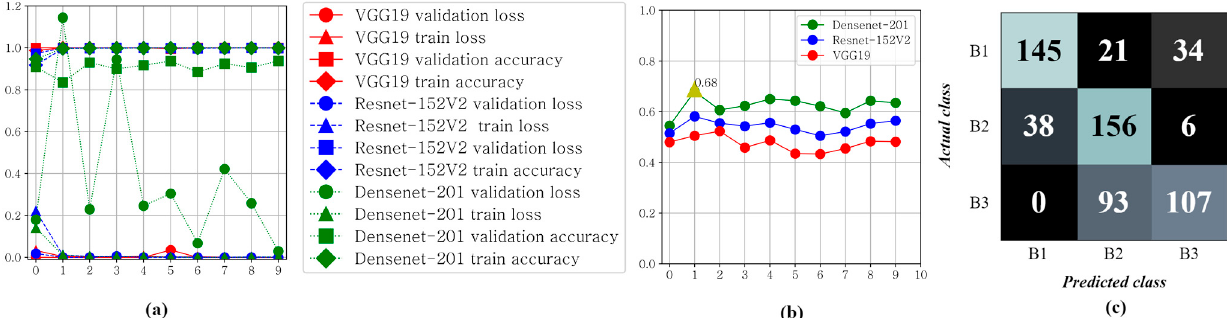
Figure 3. Training history and prediction results in Non-Thr dataset experimental environments: ( a ) Training history of Non-Thr dataset experimental envorinment; ( b ) Prediction accuracy of CNN models at each epoch; ( c ) Confusion matrix of Non-Thr Densenet-201 2.